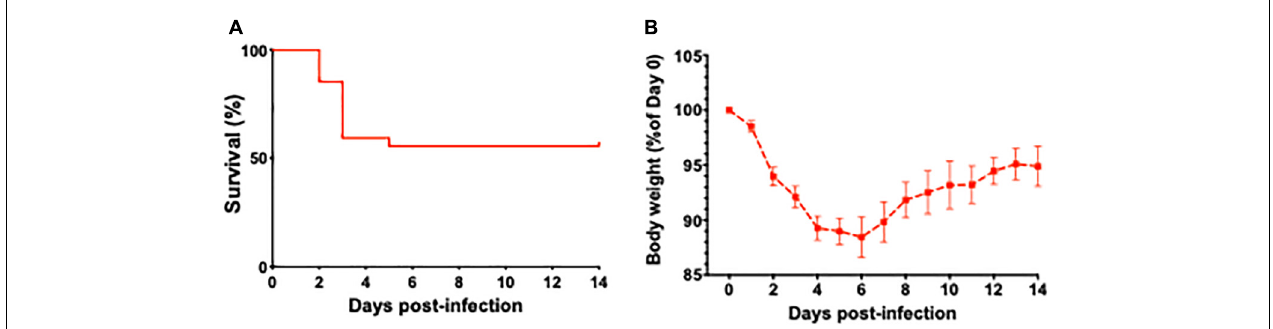
FIGURE 1 | The effect of L. monocytogenes induced sepsis on mortality rates and body weights in aged mice. (A) Survival curve of 24-month-old mice after L. monocytogenes infection and antibiotic treatment. Over the course of the experiment, 13 out of 27 L. monocytogenes infected mice died due to sepsis. Antibiotic treatment was initiated 48 h post-infection. (B) Time course of changes in body weight associated with L. monocytogenes induced sepsis in aged mice.